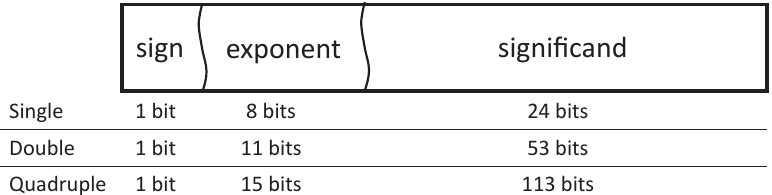
Figure 2. IEEE-754 floating-point format.